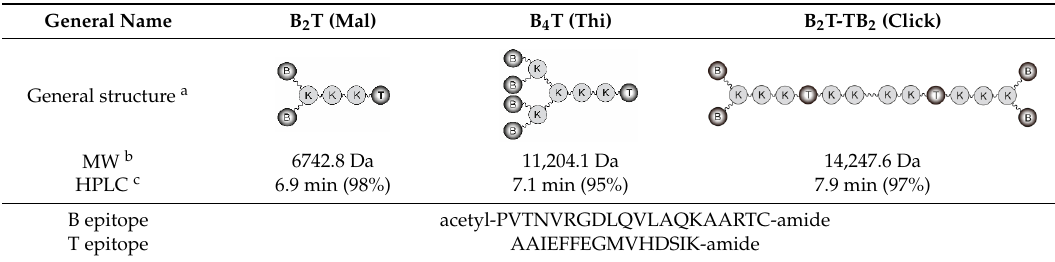
Table 1. Peptide-based vaccine candidates.